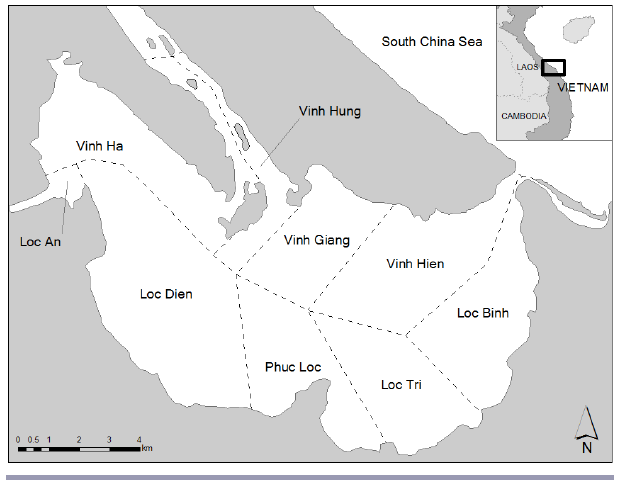
Fig. 1 . Communes and towns around the Cau Hai lagoon, central Vietnam. Dotted lines indicate the territories within the lagoon typically occupied by each